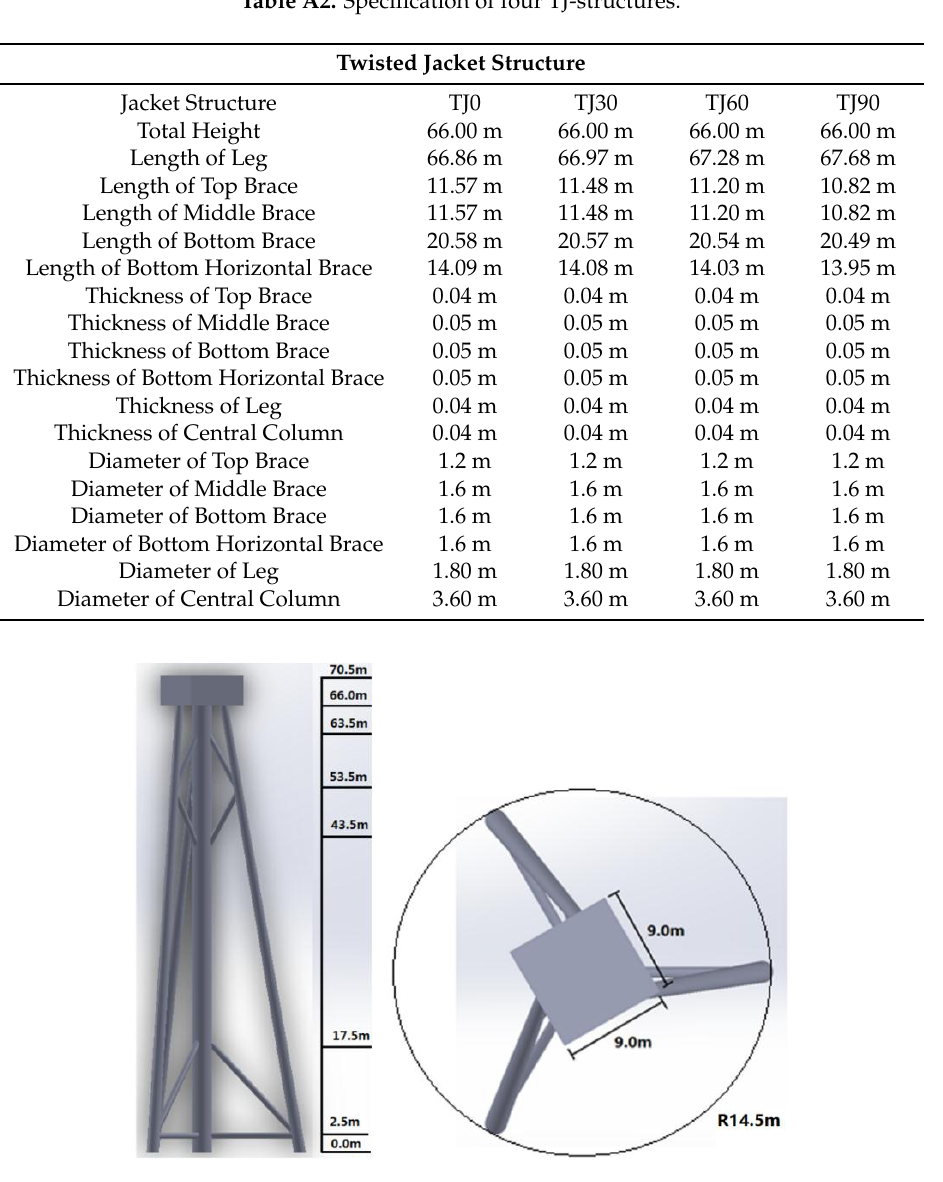
Figure A4. Illustration for the definition of the twisted angle. Table A2. Specification of four TJ-structures.